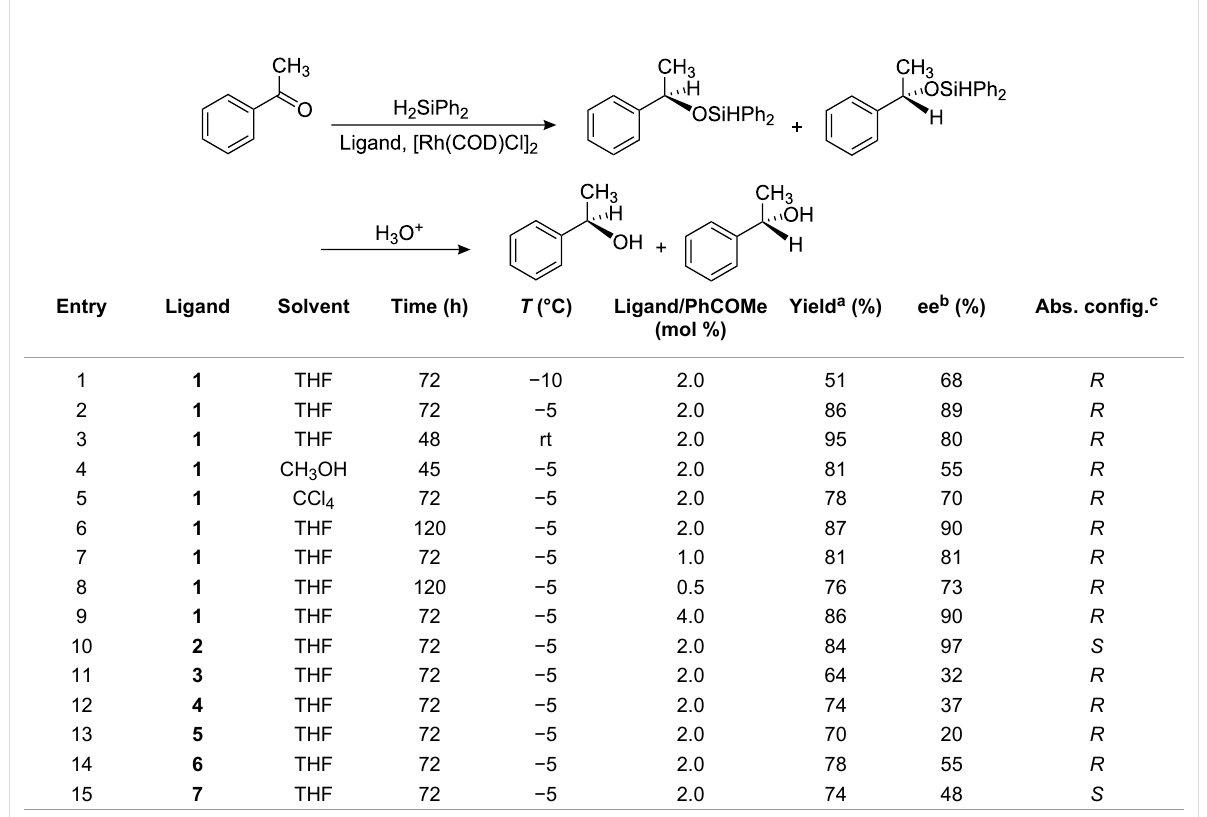
Table 2: Enantioselective Rh(I)-catalyzed hydrosilylation of